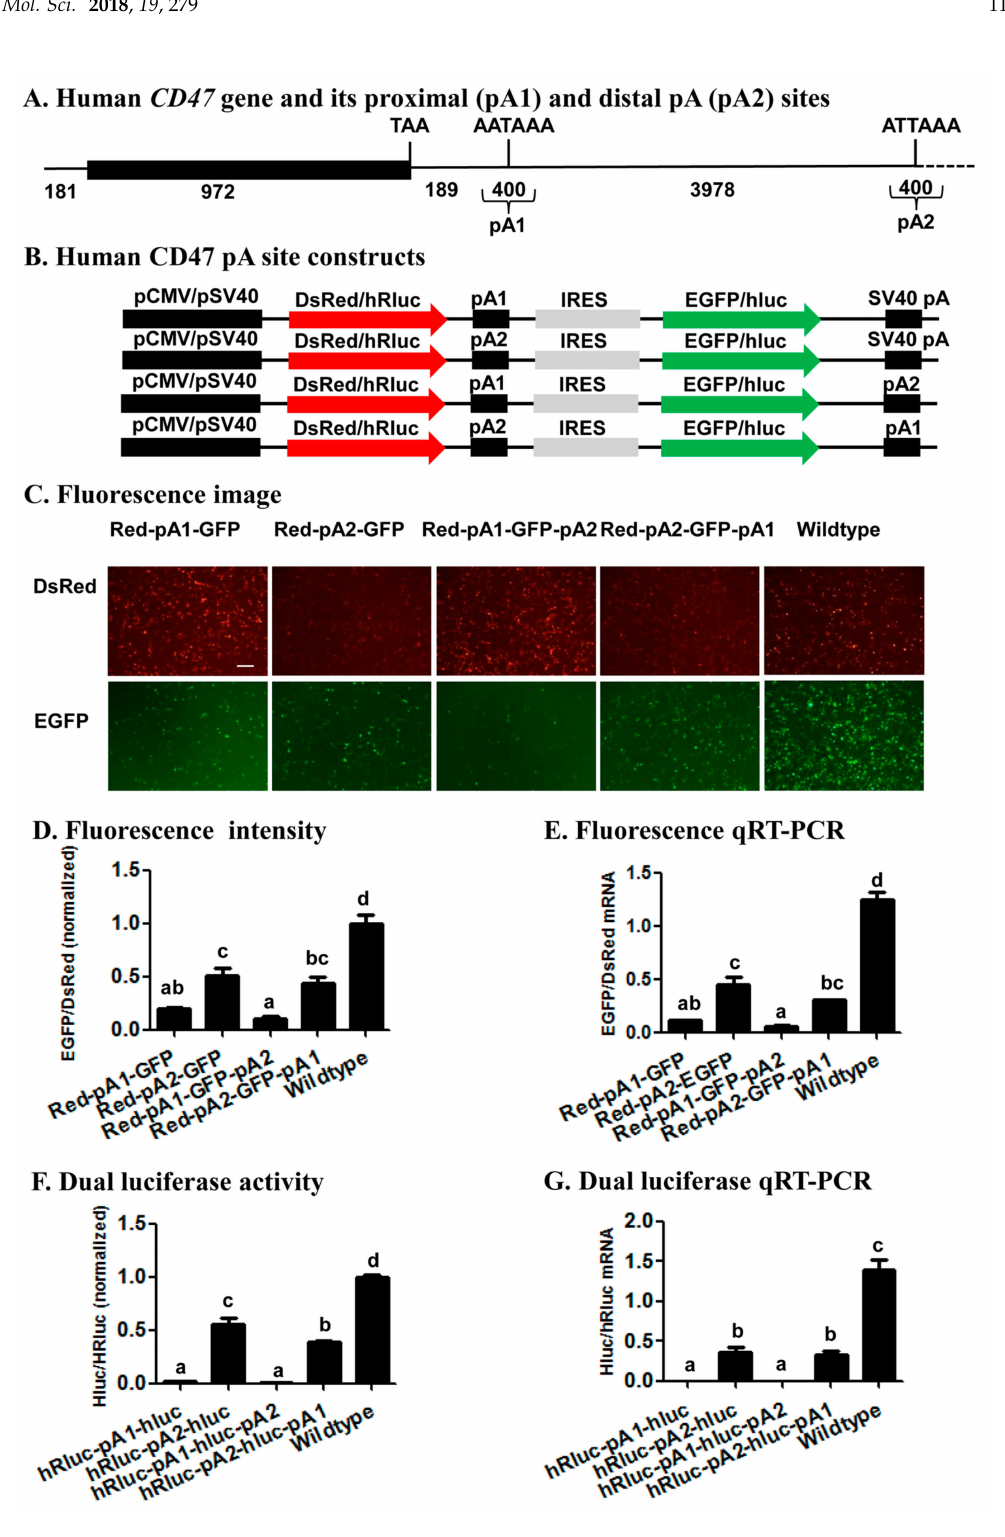
Figure 6. The relative strength of two alternative APA sites from the human CD47 gene. ( A ) Human CD47 gene and its proximal (pA1) and distal pA (pA2) sites; ( B ) Human CD47 pA site constructs; ( C ) Fluorescence image. Showed here is a representative HEK293 cell image of 3 independent transfections per construct with a scale bar of 50 µ m; ( D ) Fluorescence intensity; ( E ) Fluorescence qRT-PCR; ( F ) Dual luciferase activity; ( G ) Dual luciferase qRT-PCR. The data and error bars in ( D – G ) represent the means and standard errors of at least three independent transfections for each CD47 pA site construct. Values sharing the same letter are not significantly different at p < 0.05 (Tukey’s HSD